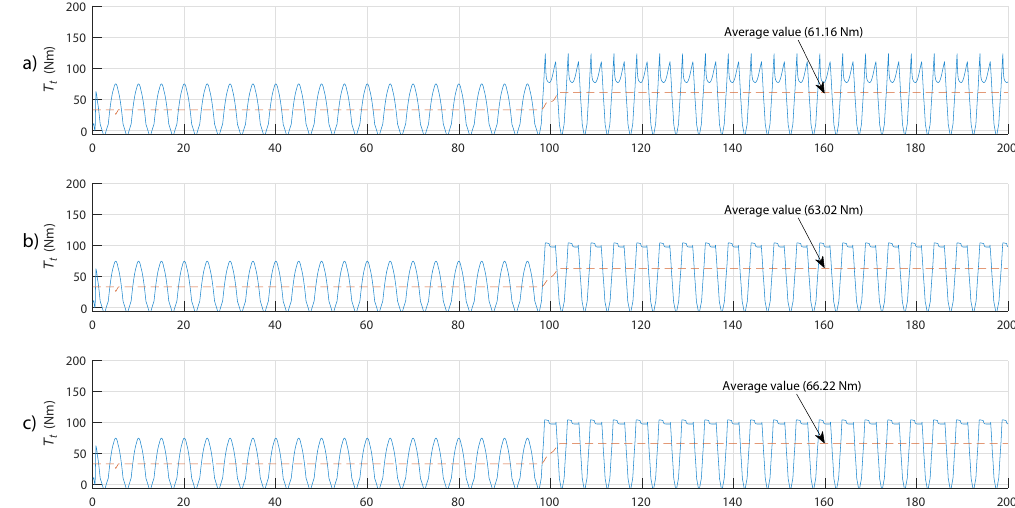
Figure 23. Turbine torque for the OWC. ( a ) Uncontrolled case. ( b ) ANN1-rotational speed control. ( c ) ANN2-rotational speed control.